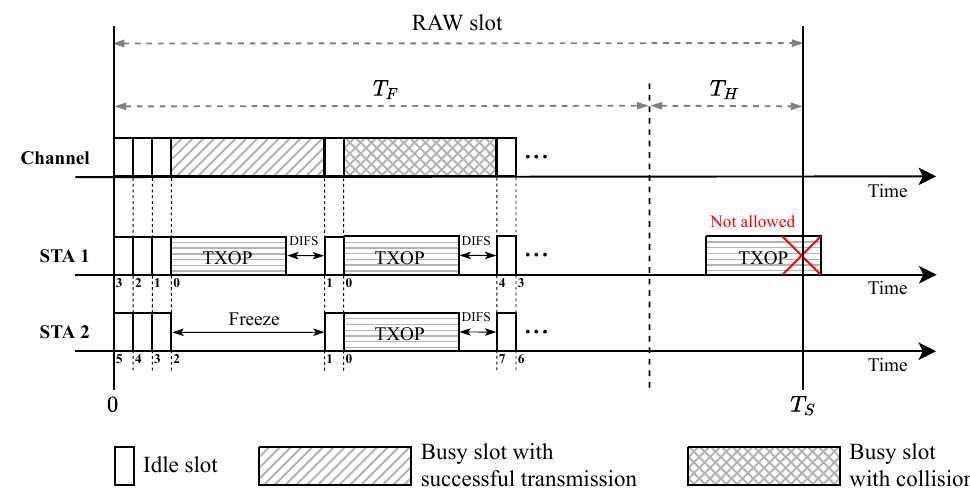
Figure 4. Structure of RAW